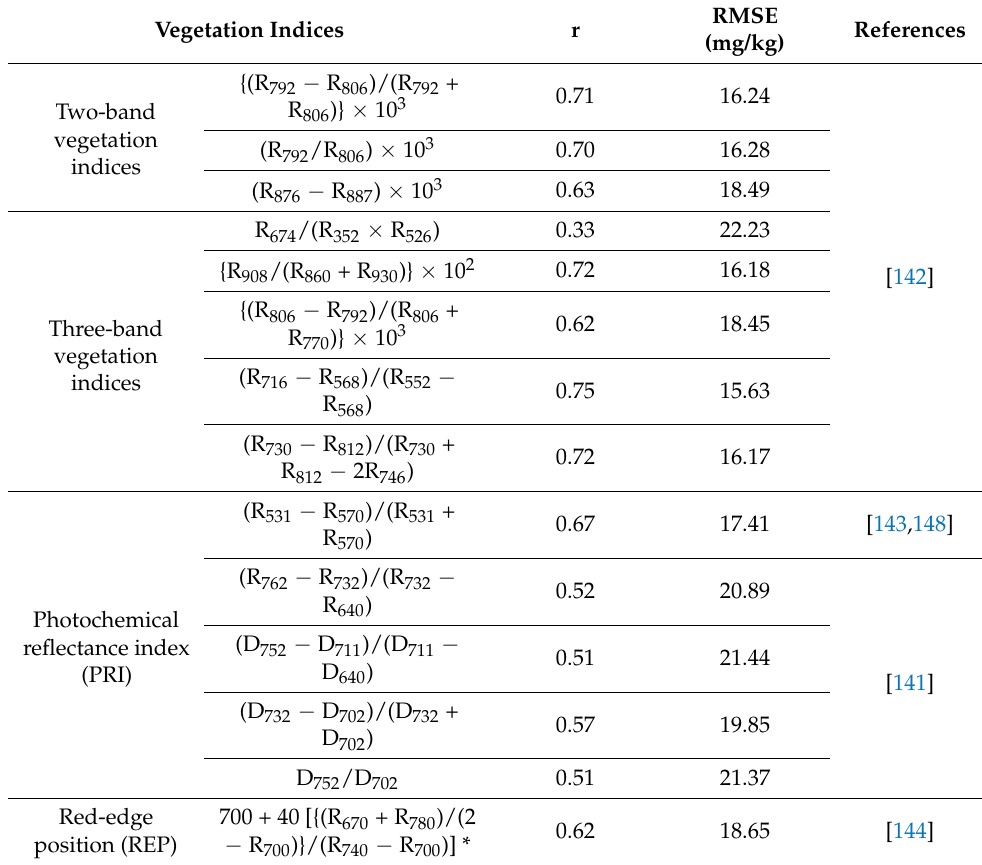
Table 4. Estimation of soil As concentration using multivariate vegetation indices with the validation results, modified from Shi et al., 2016 [142].